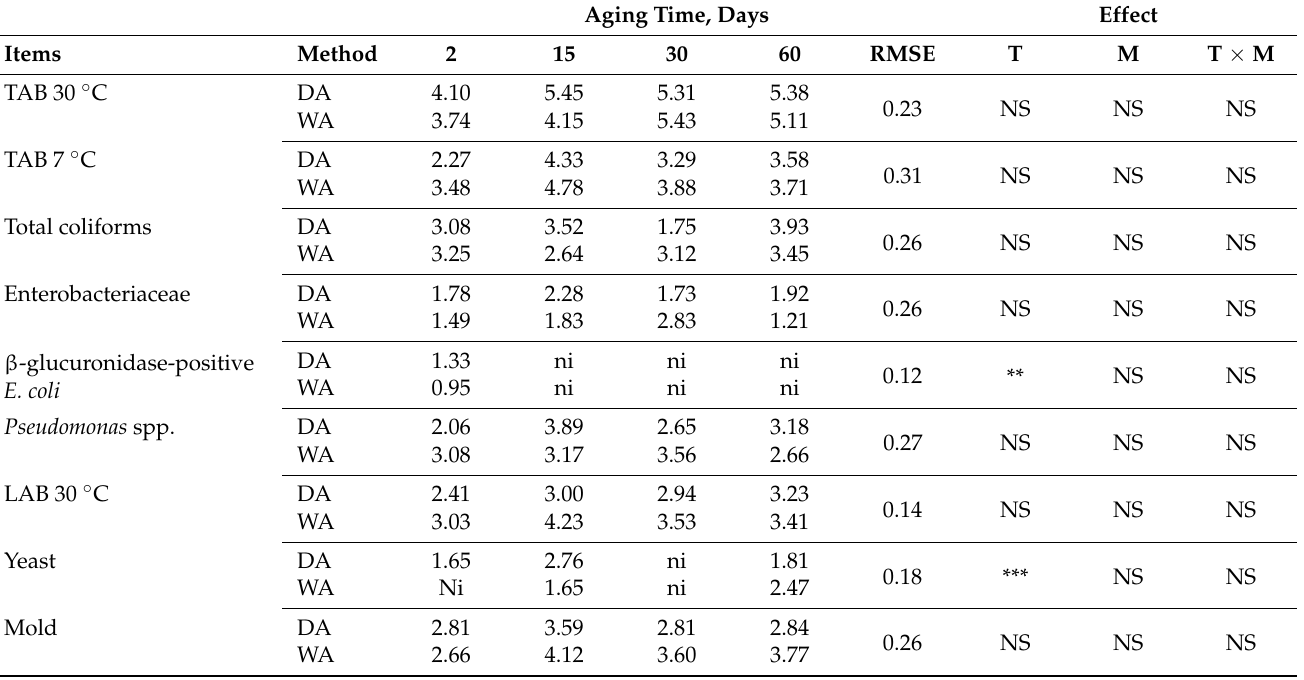
Table 6. Effects of different aging methods and aging times on the microbial population (log colony- forming unit (cfu)/g) in Charolais meat cuts ( Longissimus dorsi (LD) and Semitendinosus (ST)) aged by different methods (dry-aging (DA) and wet-aging (WA)) for 60 days. Aging Time, Days Effect